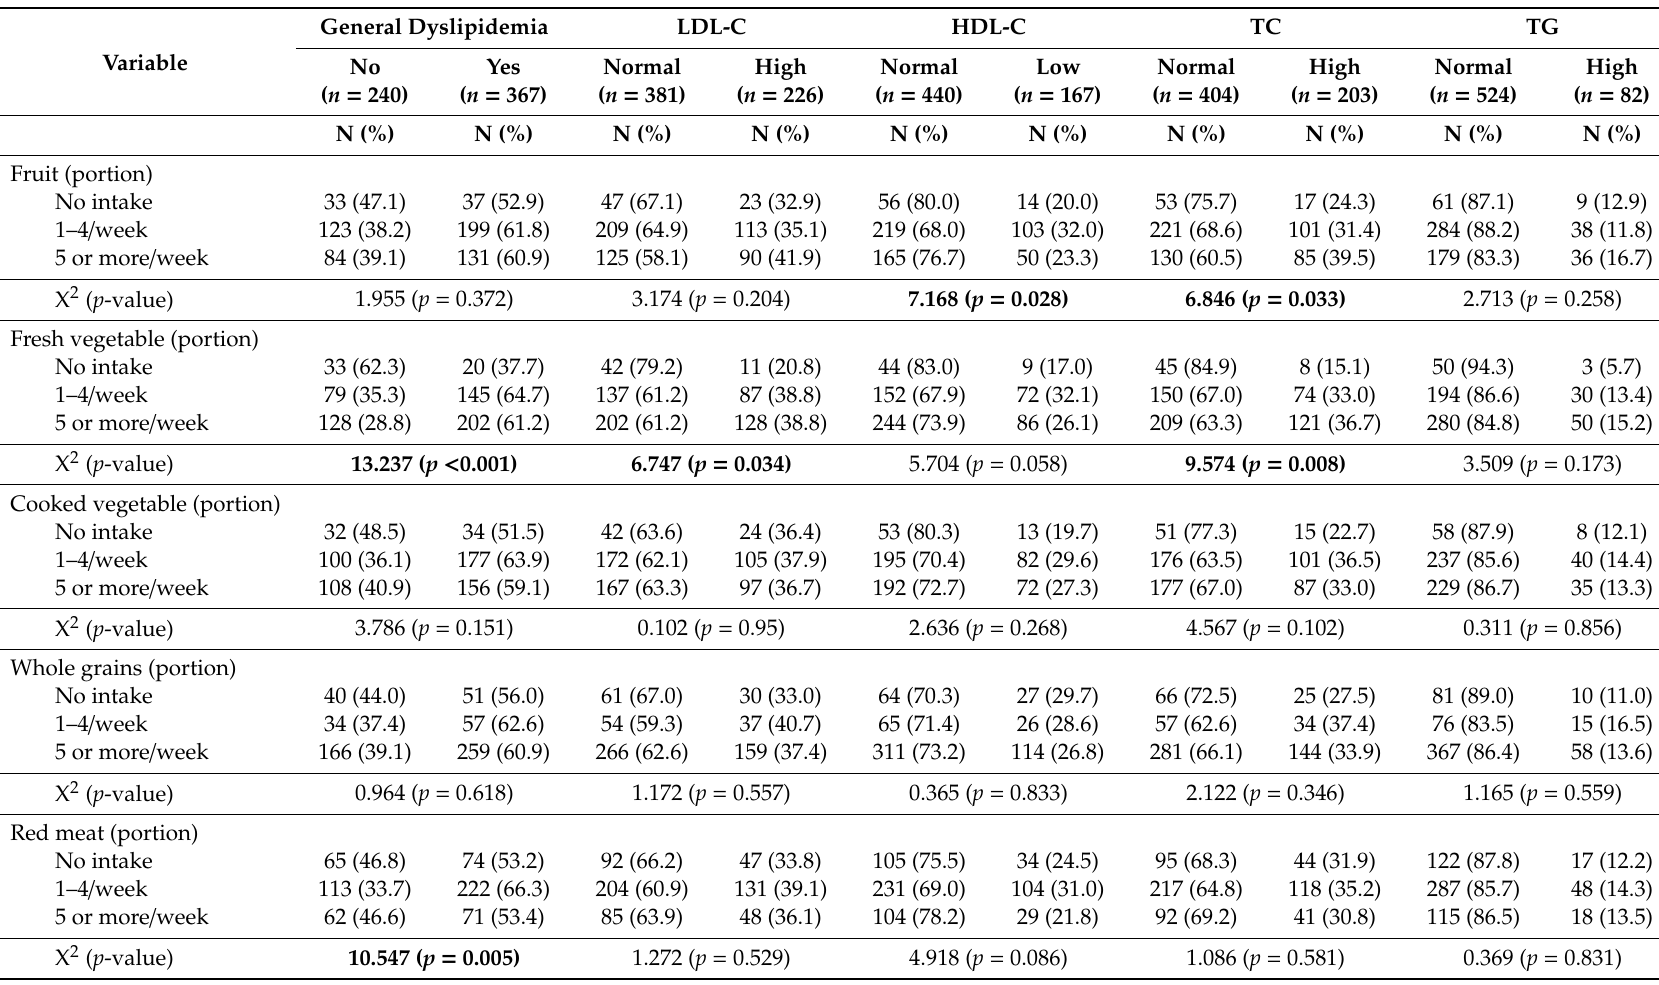
Table 4. Comparison of dietary habits between normolipidemic and dyslipidemic women groups presented as the number of women and (% of the group) for overall dyslipidemia, and abnormalities in di ff erent lipid